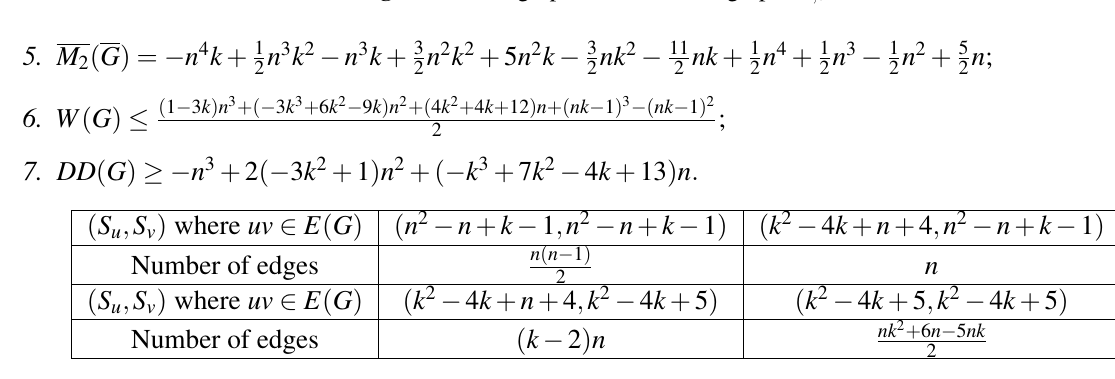
Fig. 4 The line graph of Firecracker graph F 4 , 7